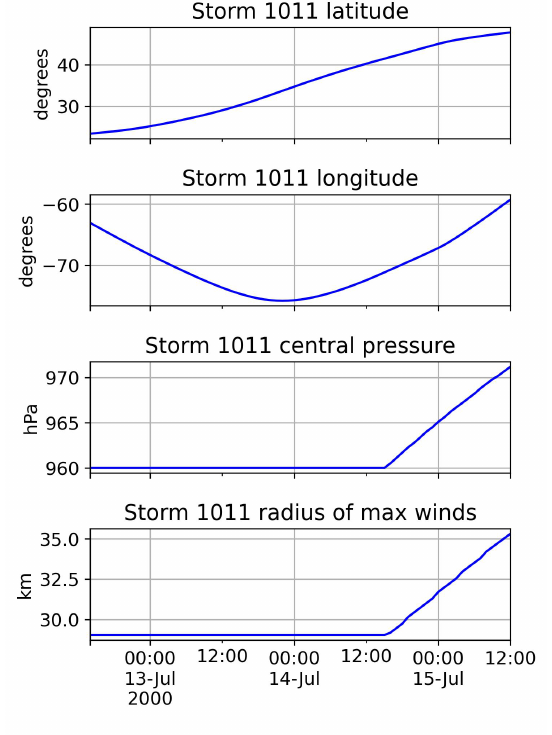
Figure 3. The time-series profiles of the storm center (i.e., longitude and latitude), the central pressure, and the radius of maximum winds of storm 1011 in the NACSS